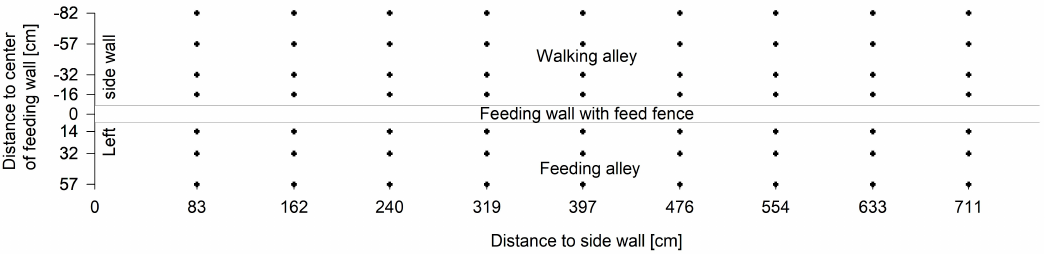
Figure 3. Coordinate grid for reading range measurements in front and behind the feed fence.